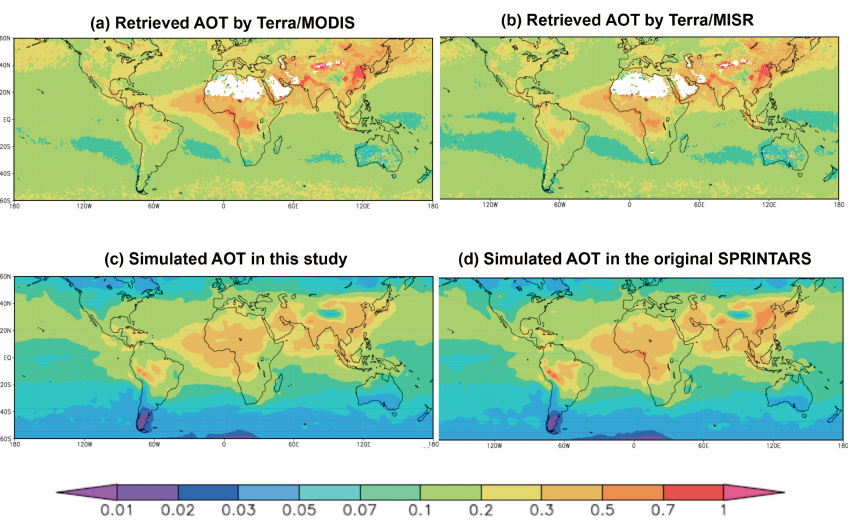
Fig. 10. Annual mean AOT distributions observed by (a) Terra/MODIS, (b) Terra/MISR, (c) NS and (d) OS, respectively, for the year